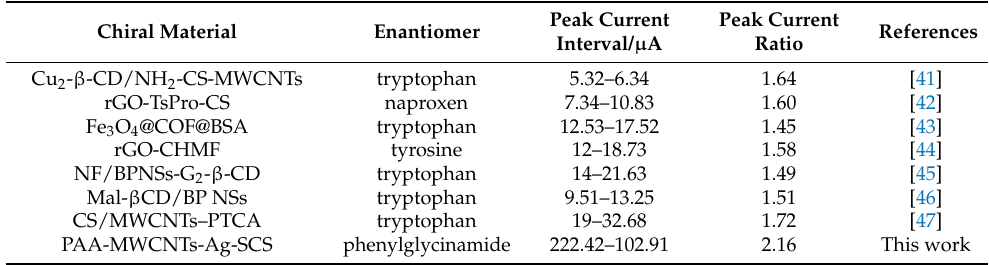
Table 1. A comparison of the developed electrochemical methods in the peak current interval and peak current